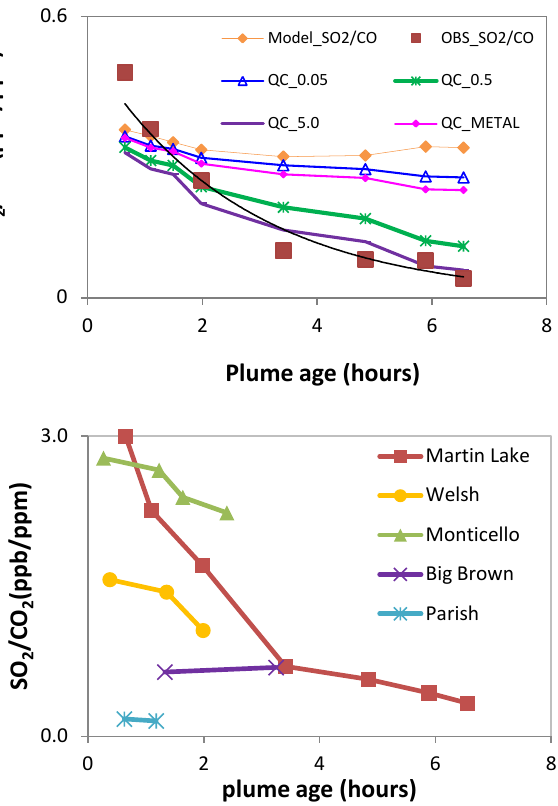
Fig. 5. (a) The observed least square slopes of SO 2 to CO (red square) and modeled ZOC SO /ZOC CO (blue diamond for the base case, green dot for the adjusted cloud case) as a function of plume age at each transect of the Martin Lake plume (16 September). The observed SO 2 loss rate was 0.38h − 1 ( R 2 =0.94, SO 2 lifetime: 2.6h); the modeled SO 2 loss rate was 0.016h − 1 ( R 2 =0.36, SO 2 lifetime: 62.5h). The SO 2 to CO slopes for each perturbation case are also plotted accordingly. (b) The observed least square slopes of SO 2 to CO 2 (ppb/ppm) for the five plumes; Martin Lake, Welsh, and Monticello plumes were observed on September 16 (cloudy day), Big Brown and Parish plumes were made on 25 September (sunny day).